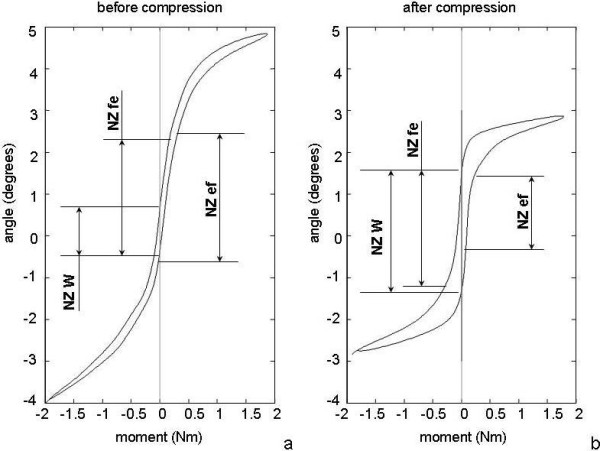
Determination of the NZ from experimental data. Load-deflection curve of a porcine lumbar segment before (a) and after a seven-hour period of axial compression under 250N (b). The NZ as determined by the method of Wilke (NZW) underestimates the NZ before the compression test, because the range of minimal stiffness is clearly larger than the angulation difference at zero load (a). The NZ as determined by the double sigmoid function (NZef, NZfe) appear to present a better estimation. After a seven-hour axial compression, the range of motion (ROM) of the segment has decreased and hysteresis has increased (b). The angulation difference at zero load (NZW) is larger than the NZ determined by the double sigmoid function. Note that in this case the NZ for extension to flexion (NZef) is smaller than the NZ from flexion to extension (NZfe).